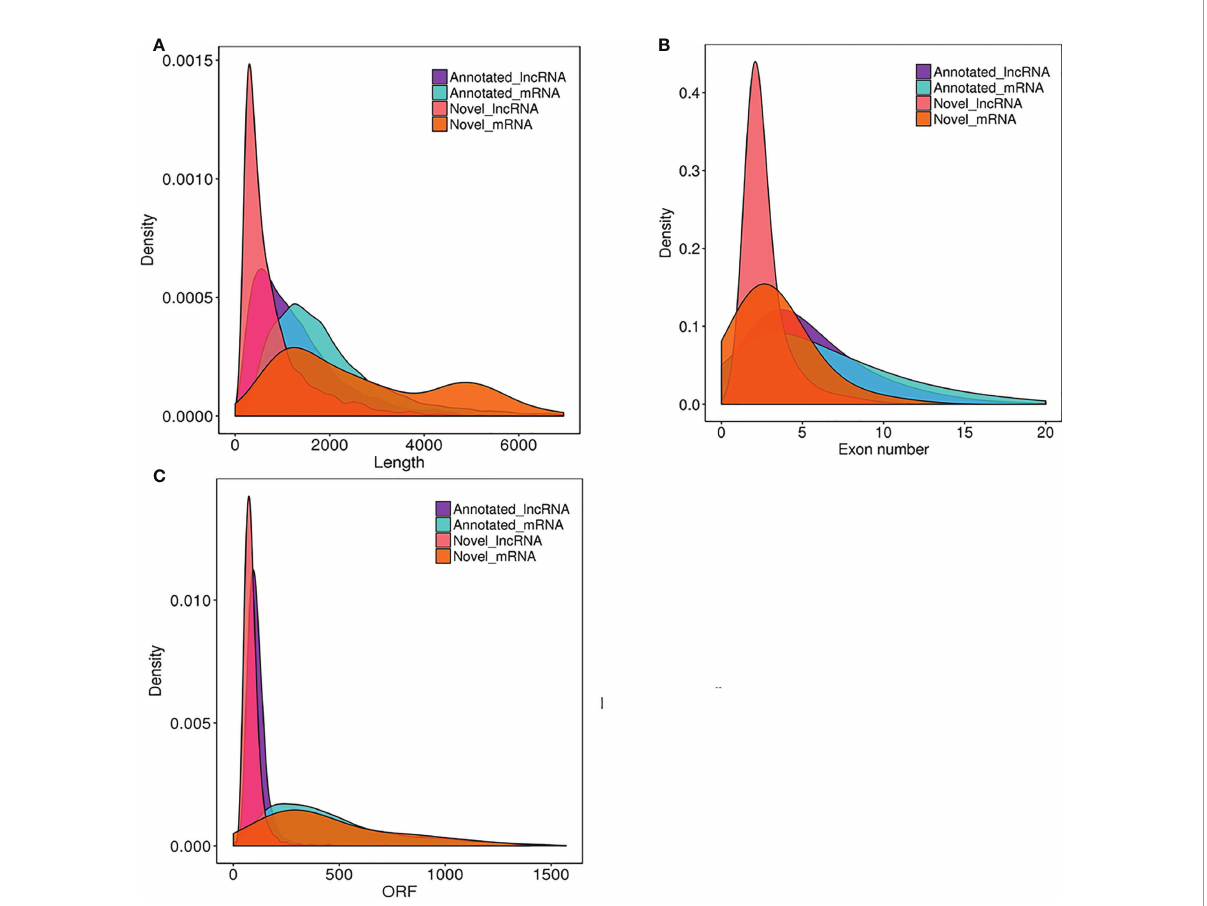
FIGURE 5 Comparison of the length, the exon number and ORF between lncRNAs and protein-coding transcripts. The distribution of length (A) , numbers of exons (B) and ORF of identi fi ed lncRNAs (C) in comparison with all protein-coding transcripts of the rose ‘ Old Blush ’